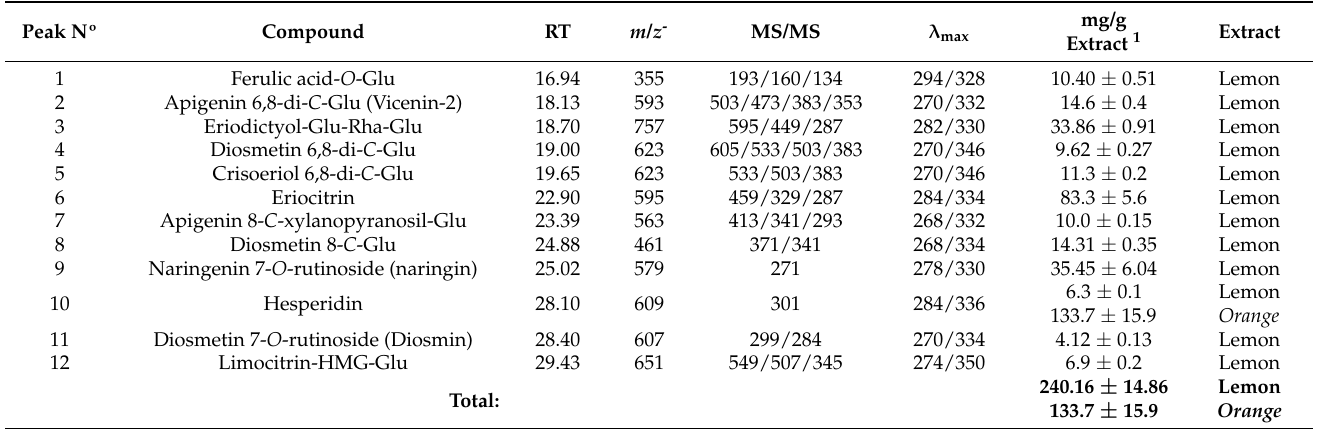
Table 2. Phenolic compounds identified in the citrus extracts by